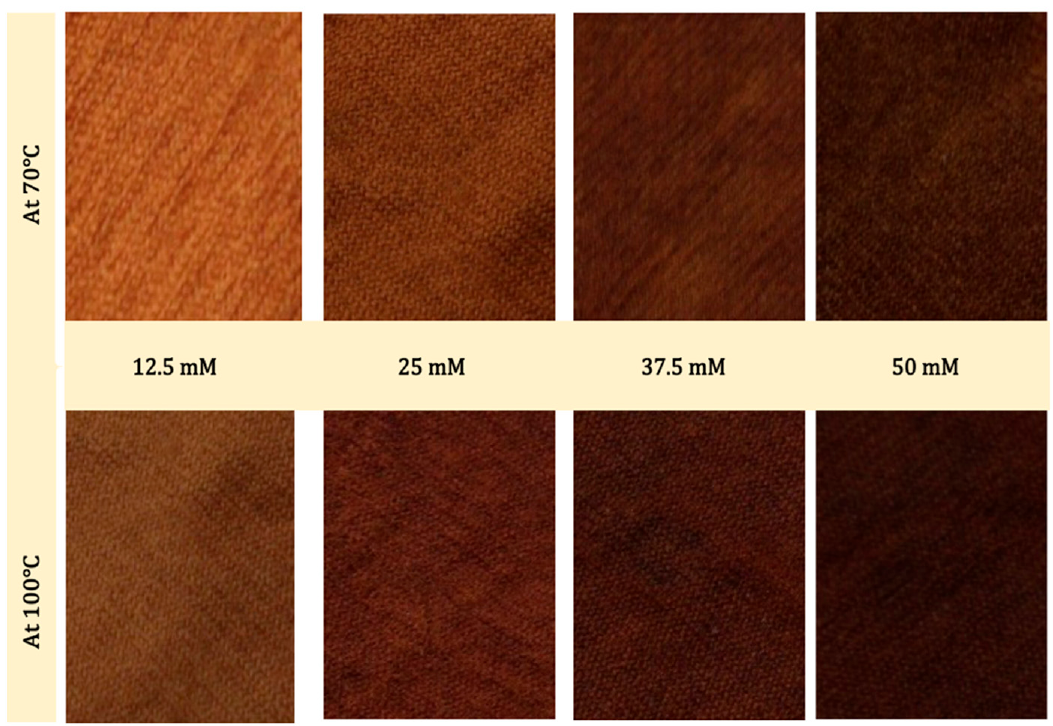
Figure 6. Photographs of Se-dyed wool fabrics with different concentrations of synthesized Se-NPs at 70 °C and 100 °C.